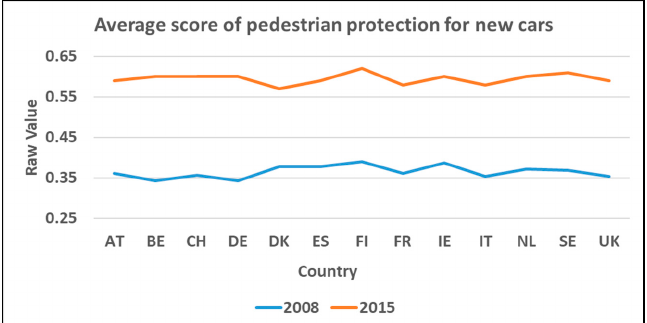
Figure 8. The change in the original values of the “Average score of pedestrian protection for new cars” indicator ( Prot_ped) for different countries over time.